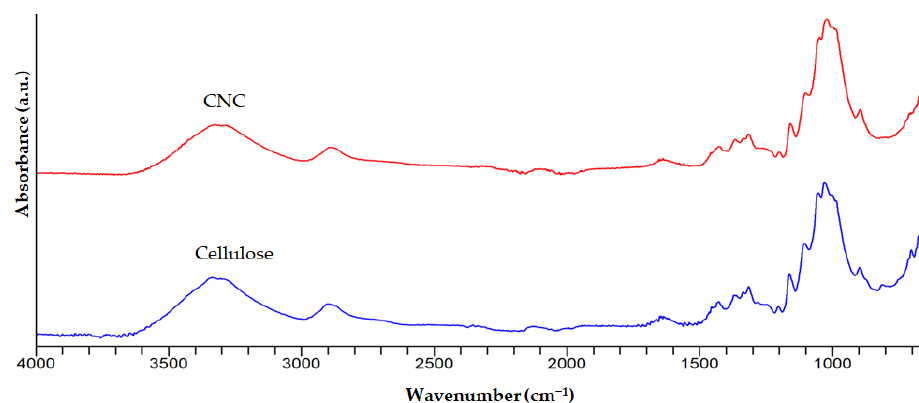
Figure 4. FTIR spectra of CNC and cellulose.